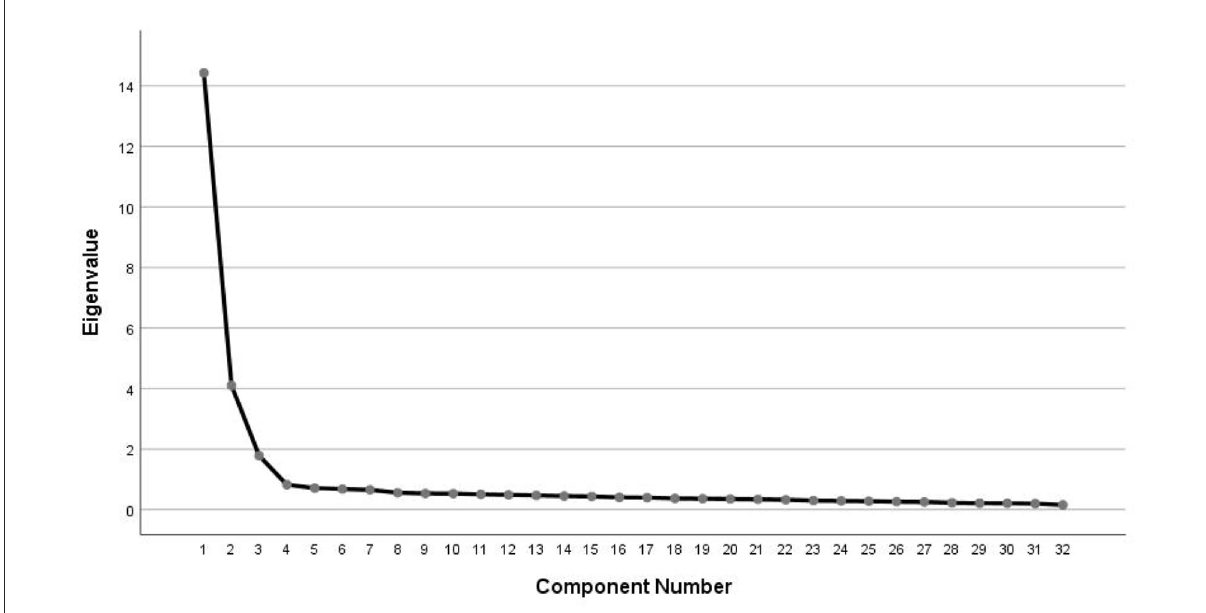
FIGURE1 Screen plot of exploratory factor analysis for Chinese version of the